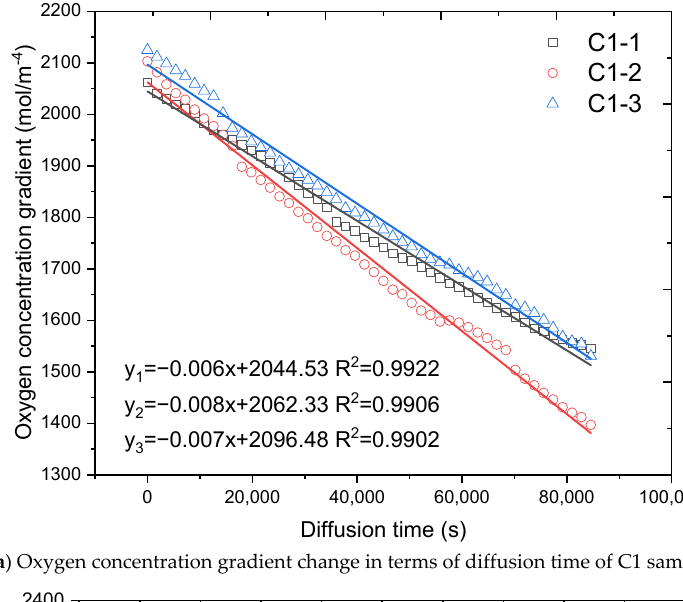
Figure 6. The reasonableness verification of Equation (5).